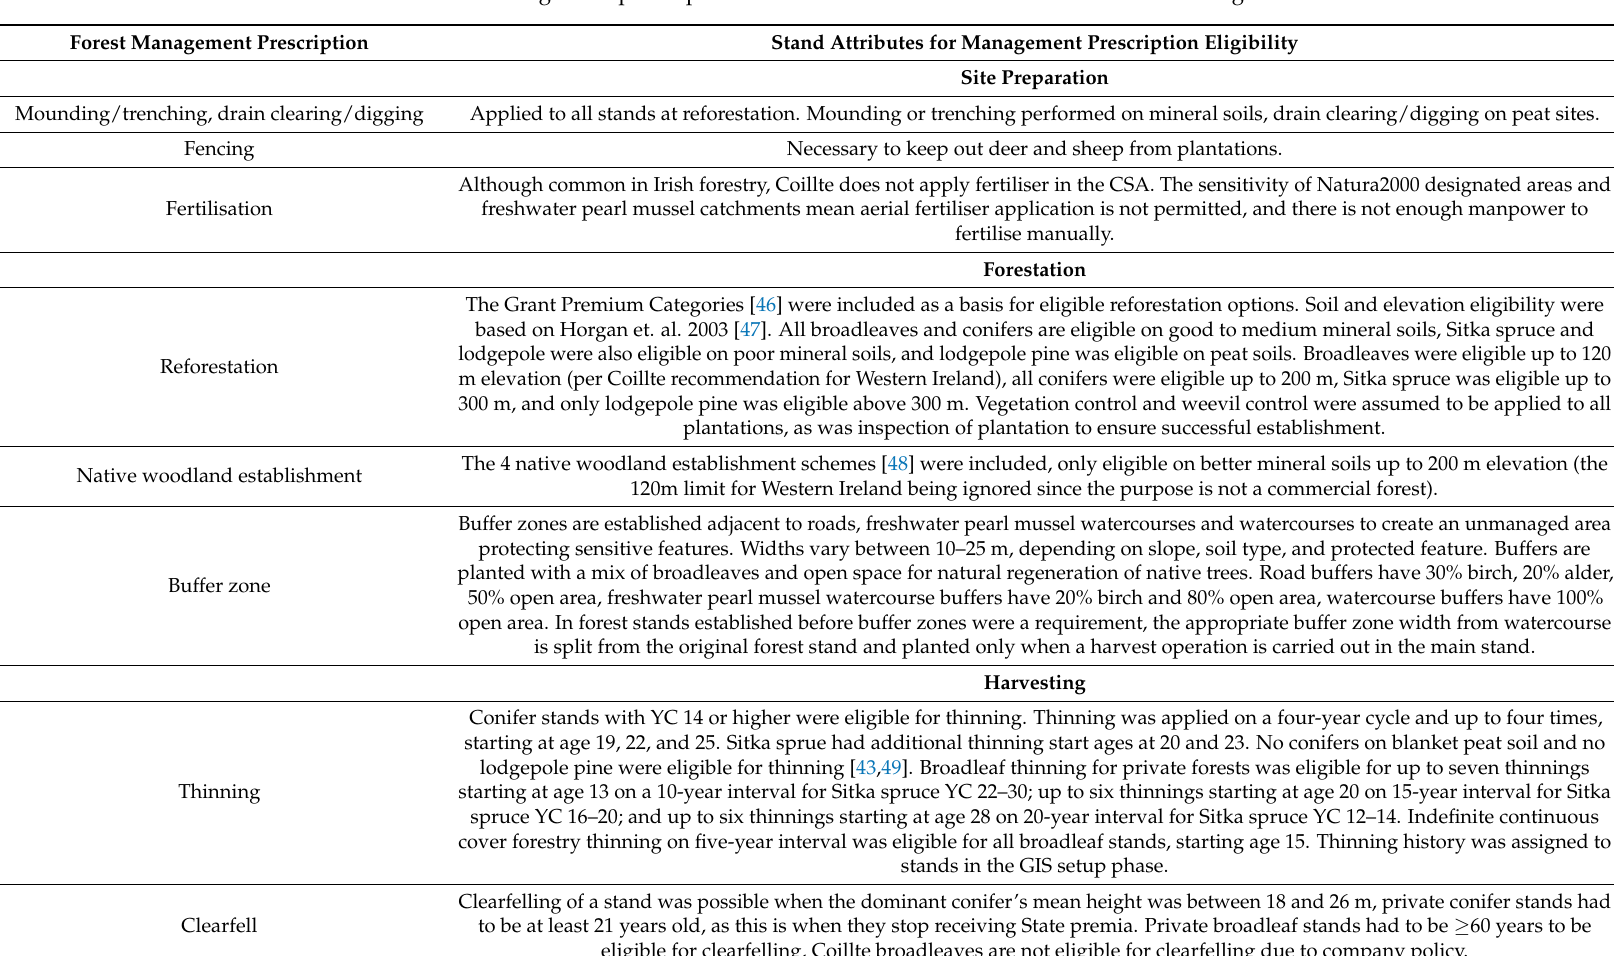
Table 5. Forest management prescriptions included in the model and the stands that are